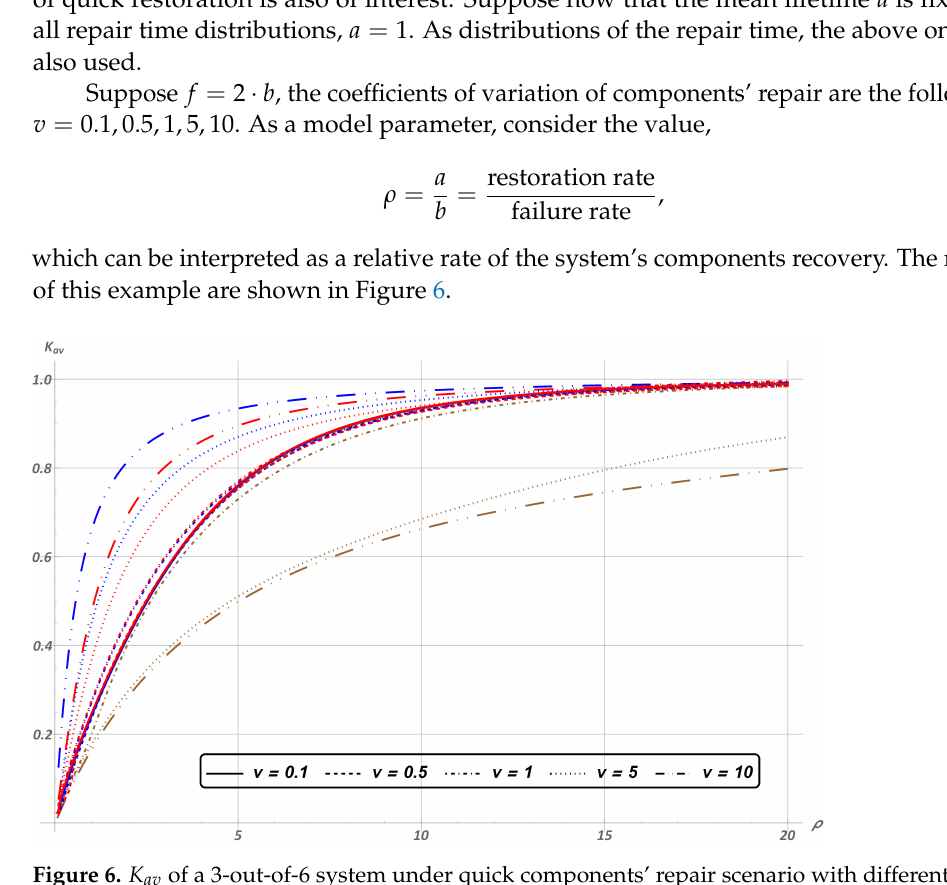
Figure 6. K av of a 3-out-of-6 system under quick components’ repair scenario with different repair time distributions B ( t ) and coefficients of variation v